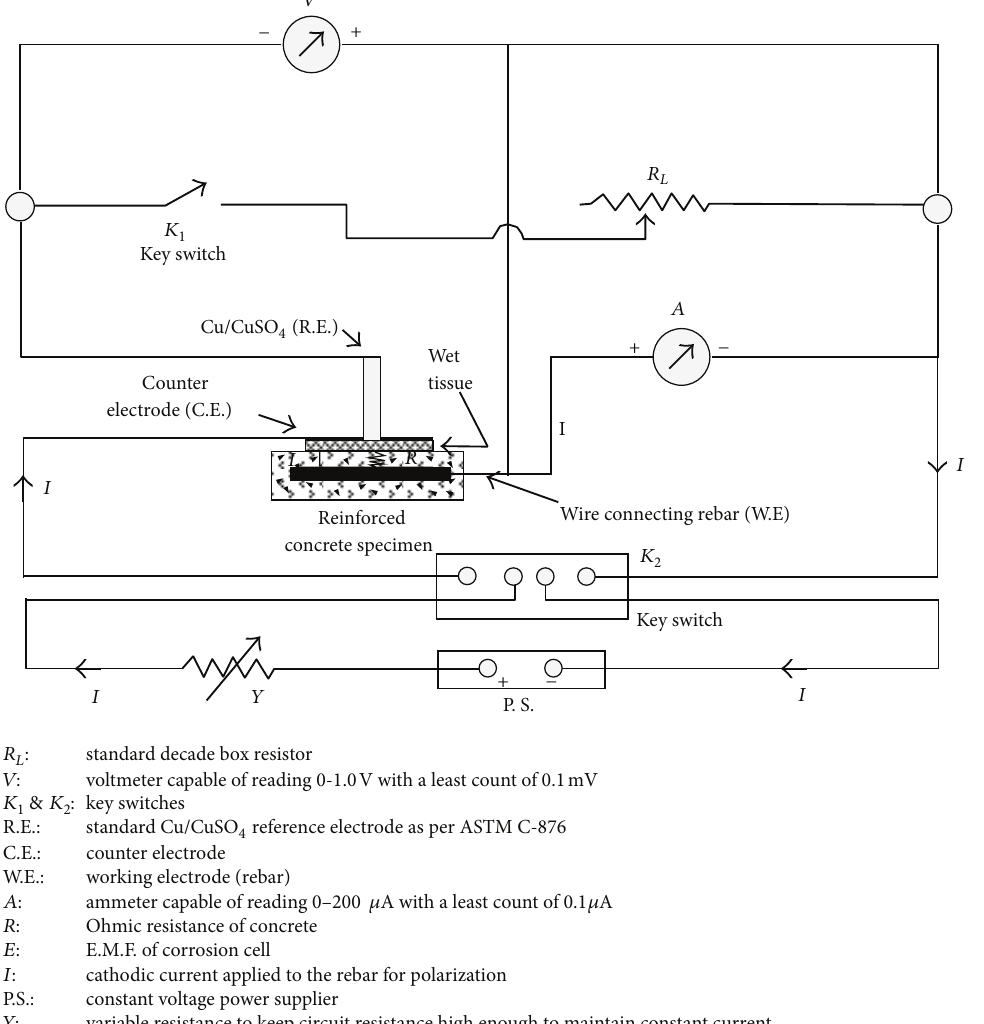
switch 𝐾 2 off. The switch 𝐾 1 permits a standard decade box resistor to be connected momentarily, whenever a voltage reading is desired, thus avoiding excessive current drain